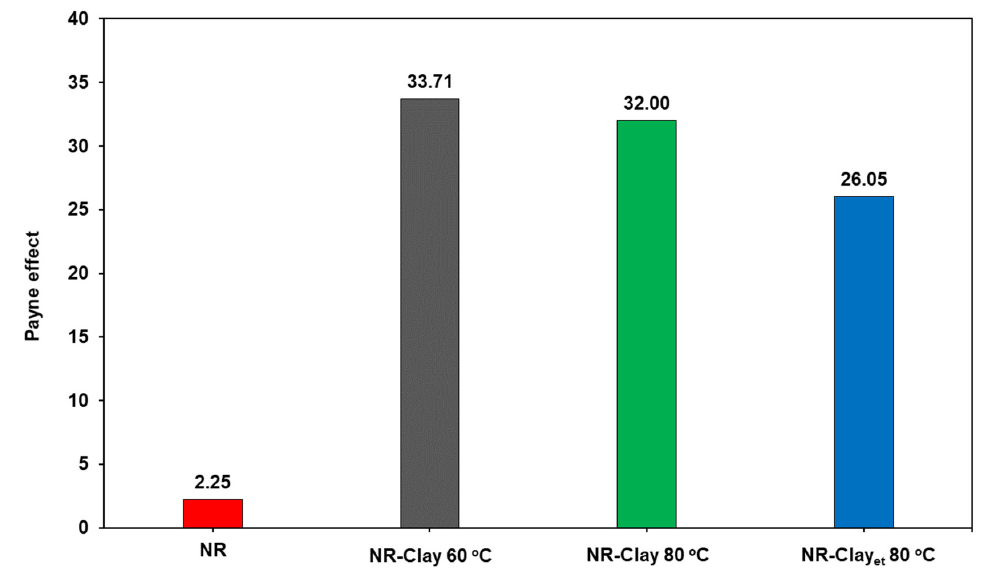
Figure 2. The Payne effect of NR, NR-Clay composites at various mixing temperatures (60 ° C, 80 ° C) and NR-Clay composites using Et-OH dispersed bentonite clay.